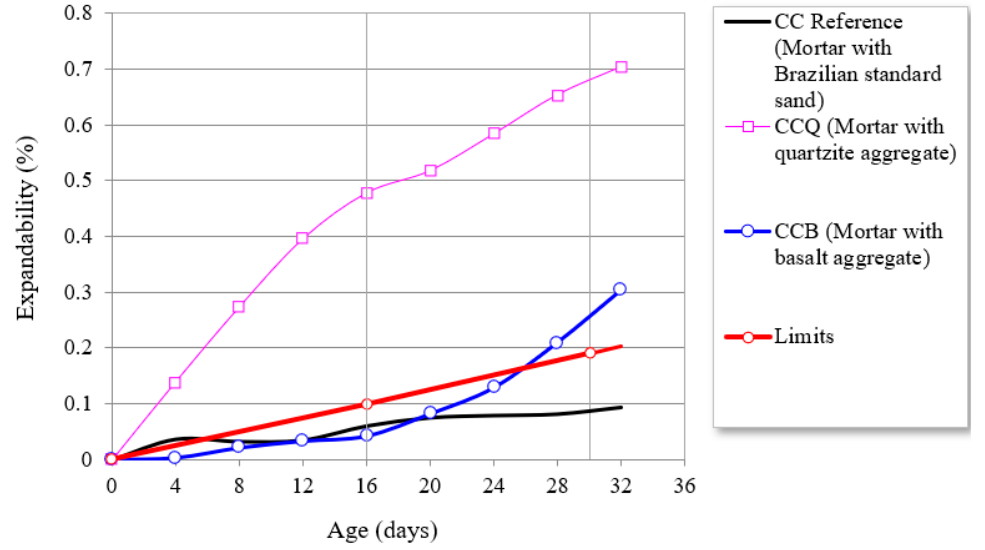
Figure 7. Comparison between the expandability of mortars developed with Brazilian standard sand, quartzite, and basalt aggregates.